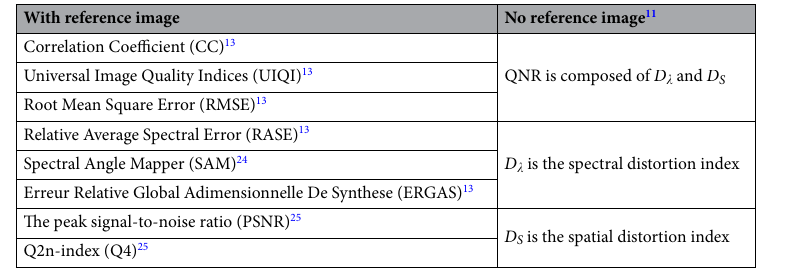
Table 1. The quantitative